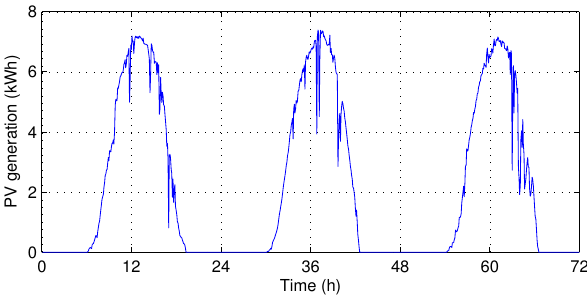
Figure 4. PV generation profile example for 3 days of campus building in GIST.